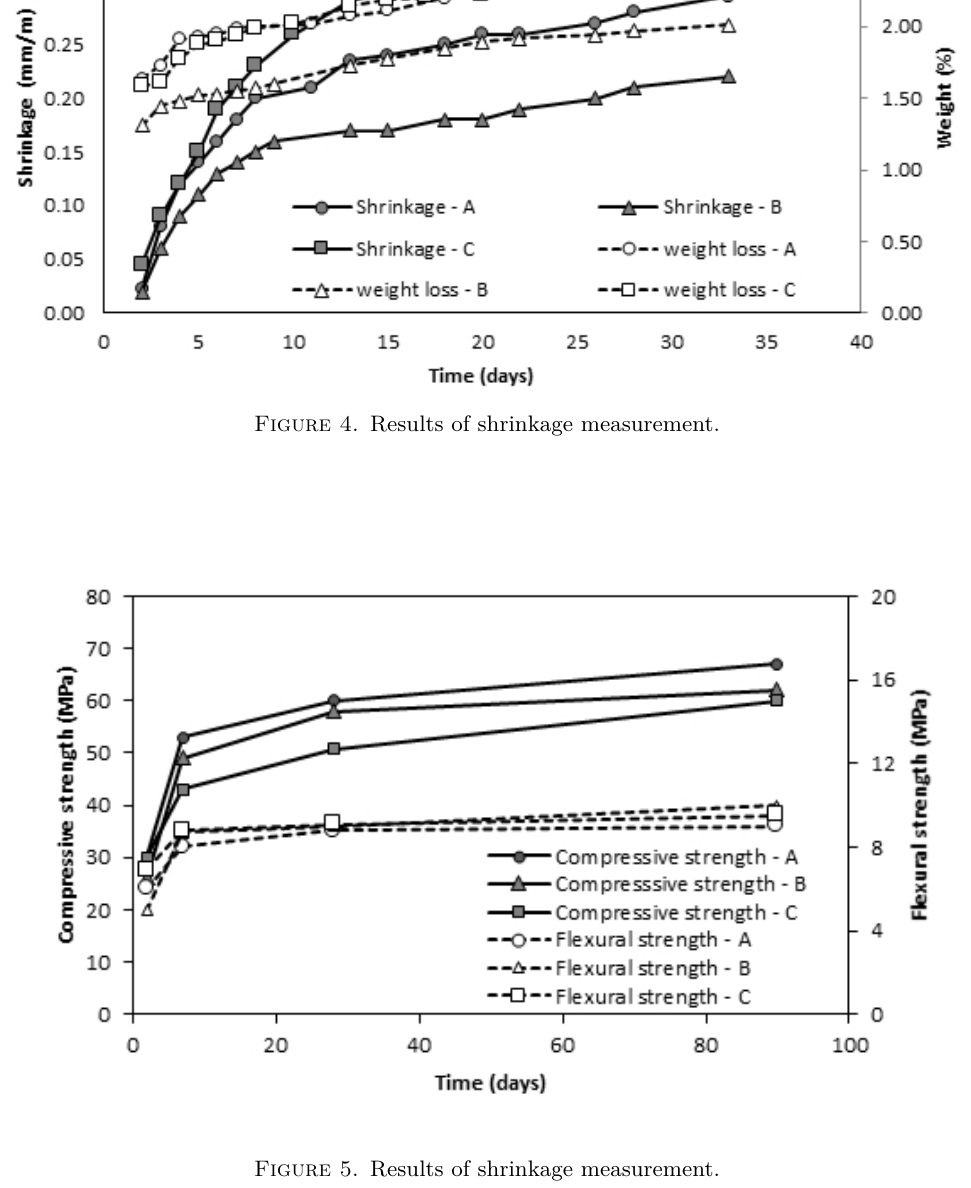
Figure 5. Results of shrinkage